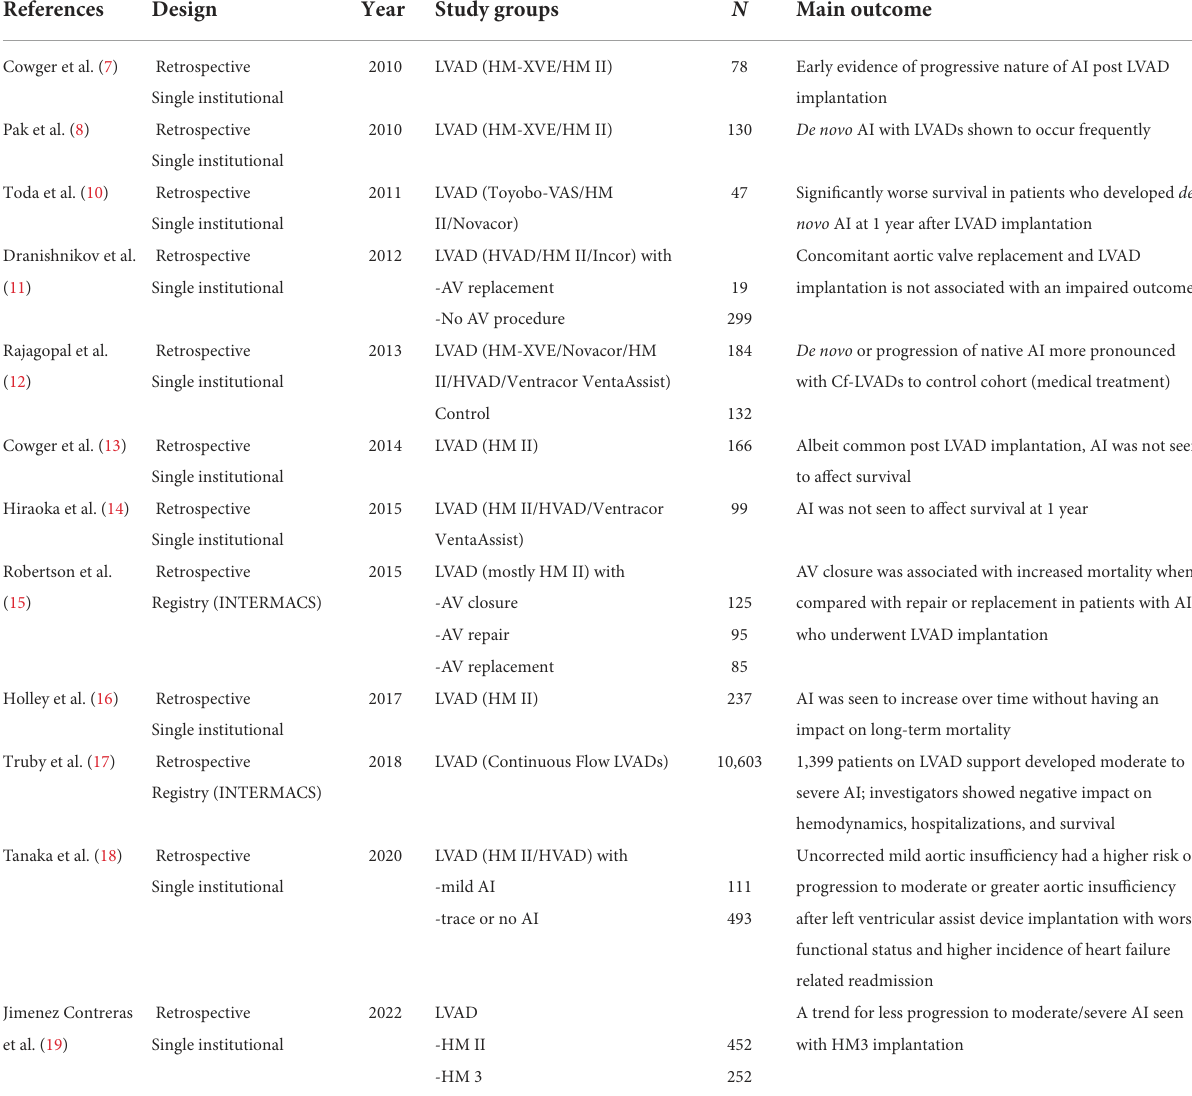
TABLE 1 Key studies in chronological order of publication reporting on the interaction of AI and LVAD